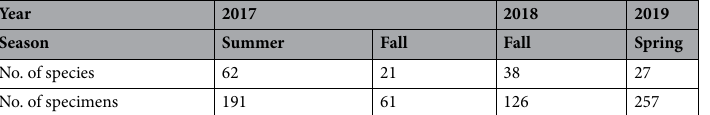
Table 2. The number of tachinid species and specimens over summer 2017 to spring 2019. The data for the summer of 2018 and 2019 is insufficient, so there is no analysis carried out.